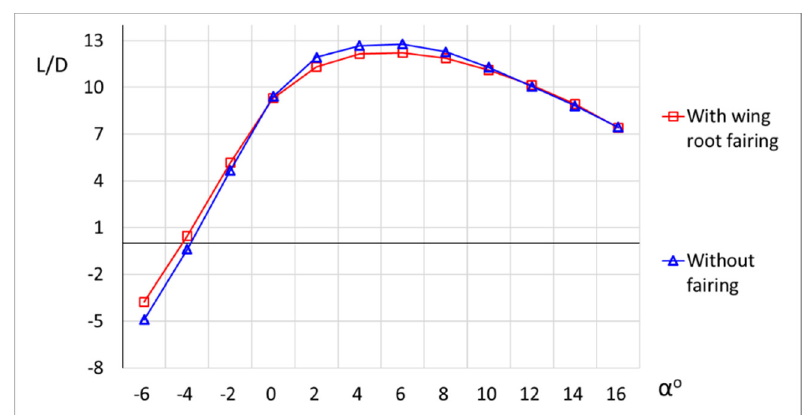
Figure 21. Lift/drag ratio of the model with and without wing root fairing.